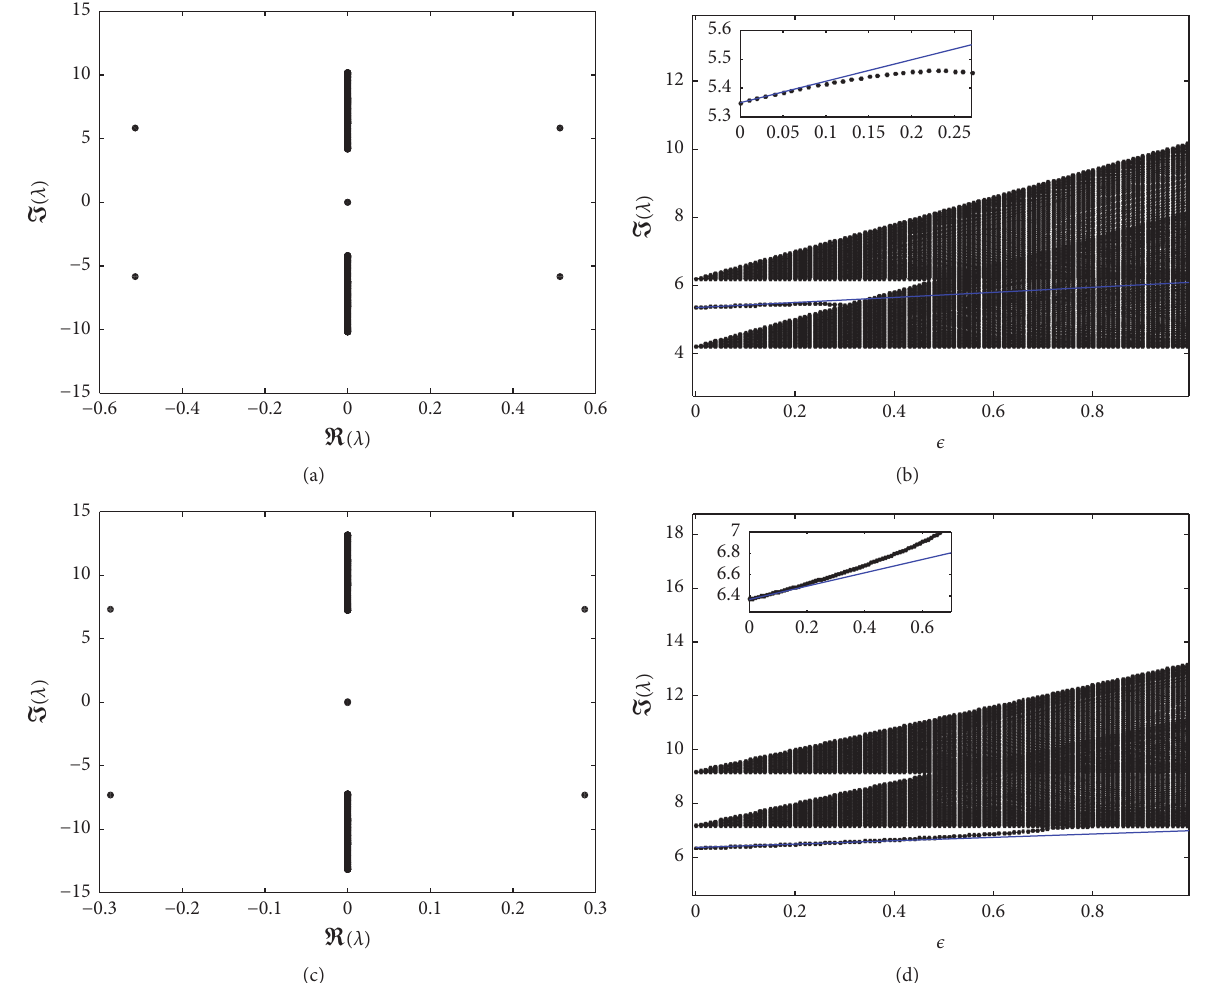
Figure 5: The same as in Figure 4, but for onsite soliton II with 𝜔 = 5.2 (a, b) and 8.2 (c, d). (a, c) are with 𝜖 = 1